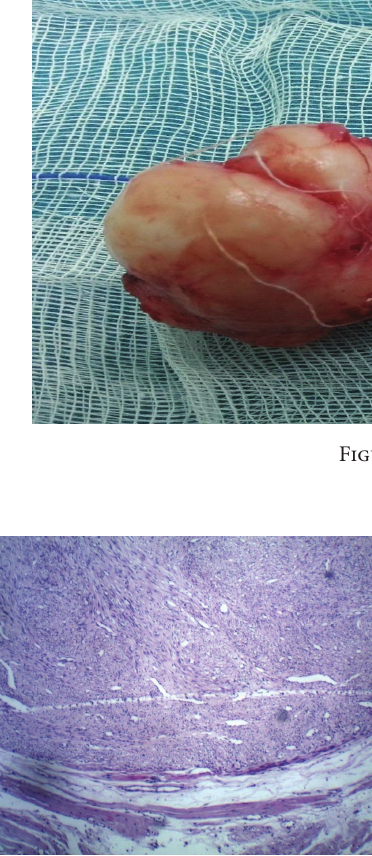
Figure 3: Histopathology showing whorls of smooth muscle fibres.